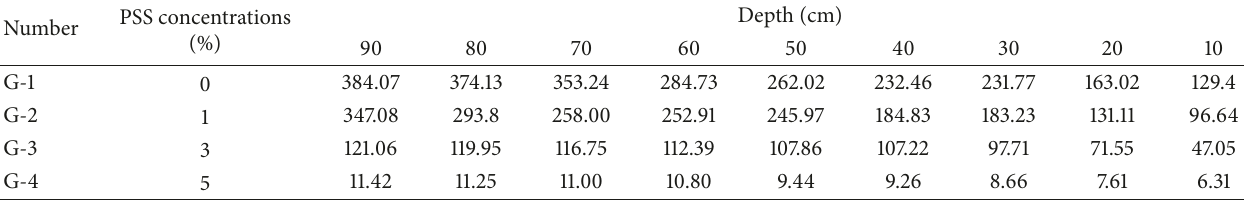
Table 5: The water flow rate at time of 12–15min of specimens with different depth